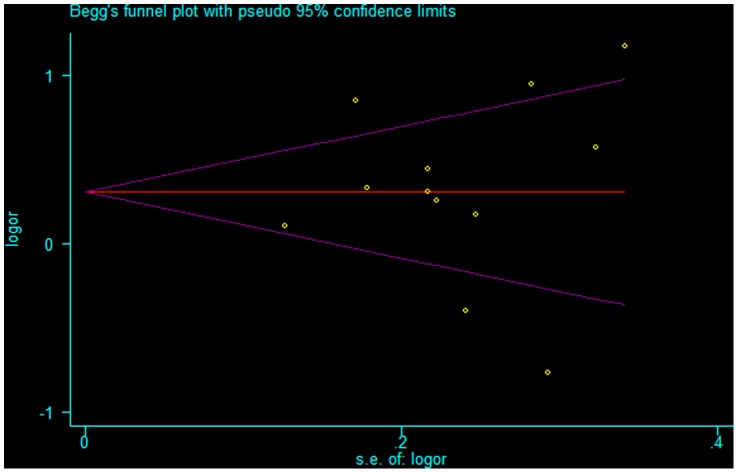
Begg’s funnel plot for publication bias test.Each point represents a separate study for the indicated association under the recessive model.